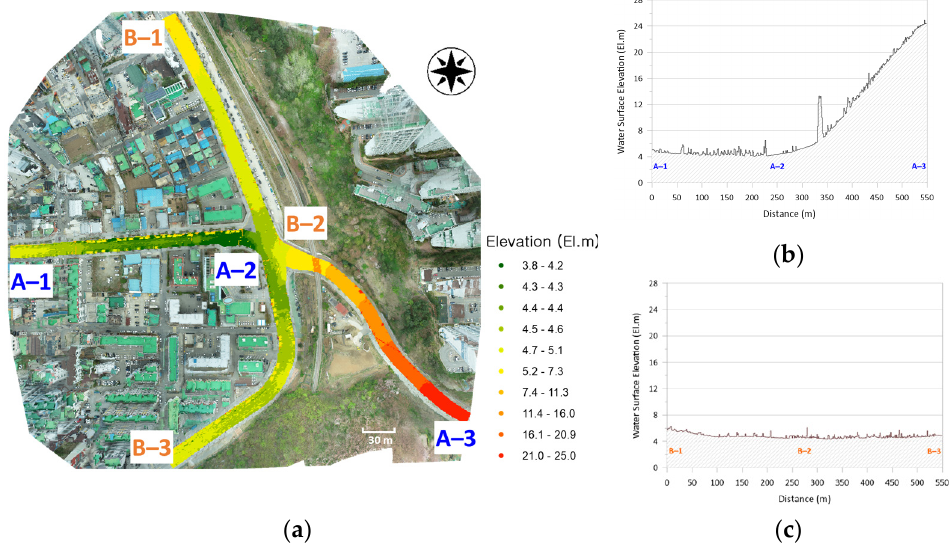
Figure 13. Elevation analysis of roads for stormwater flow: ( a ) Elevation of roads; ( b ) transverse direction of A; ( c ) longitudinal direction of B.